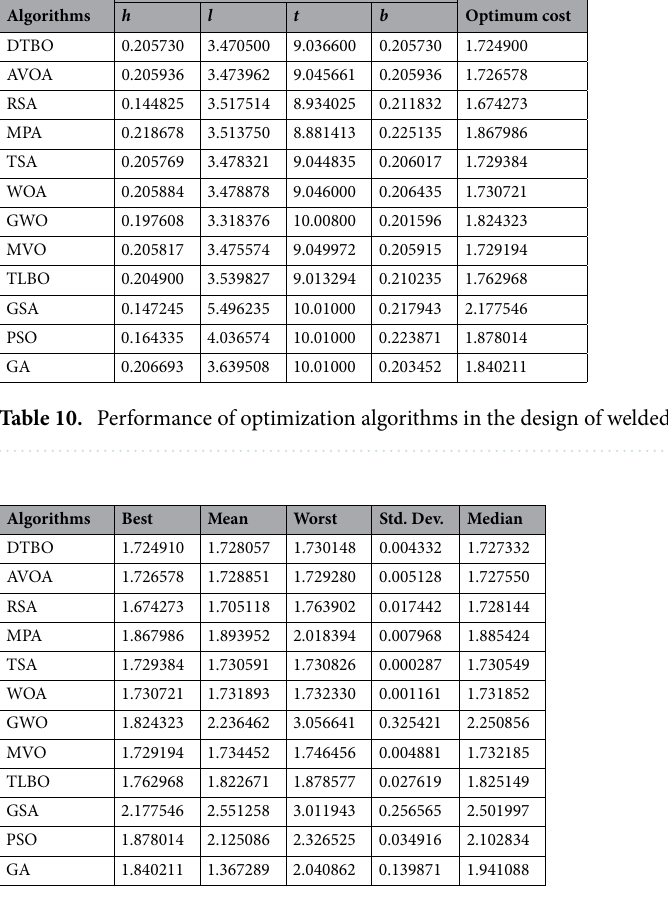
Table 11. Statistical results of optimization algorithms in the design of welded beams.